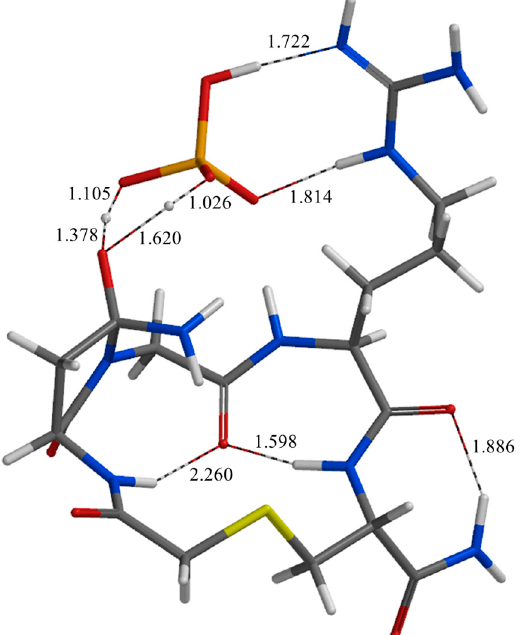
Figure 6. The geometry of TS2 (transition state 2) connecting IC1* (Figure 5) and IC2 (Figure 7). Selected interatomic distances are shown in Å. Grey: carbon; white: hydrogen; blue: nitrogen; red: oxygen; orange: phosphorus; yellow: sulfur.